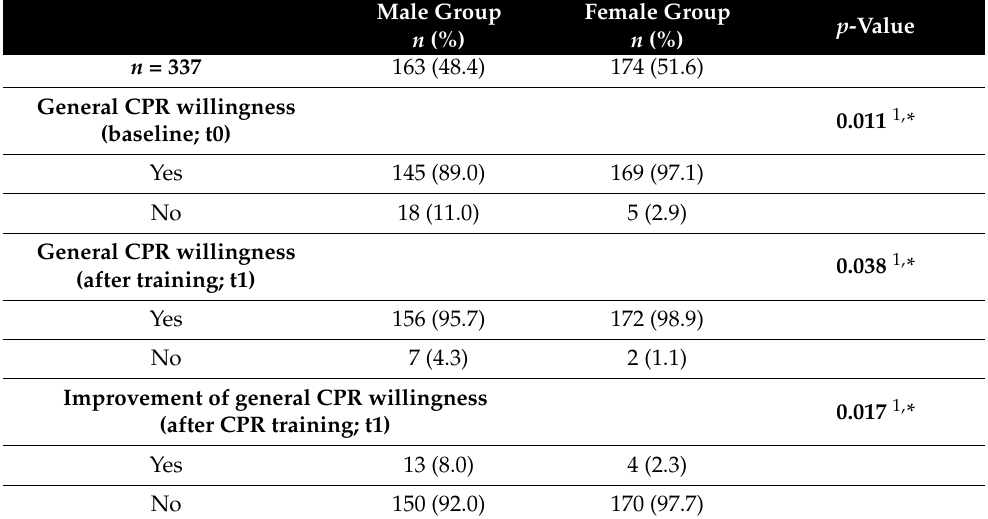
Table 2. General CPR willingness and improvement among male and female schoolchildren before and after CPR training.